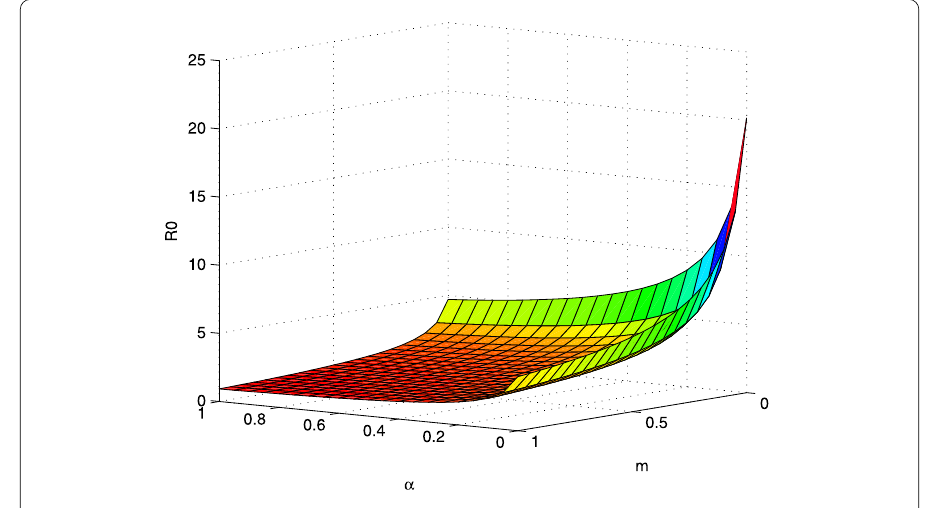
Figure 4 The dependence of the basic reproductive number on the strength of vaccination and removing infected tree.